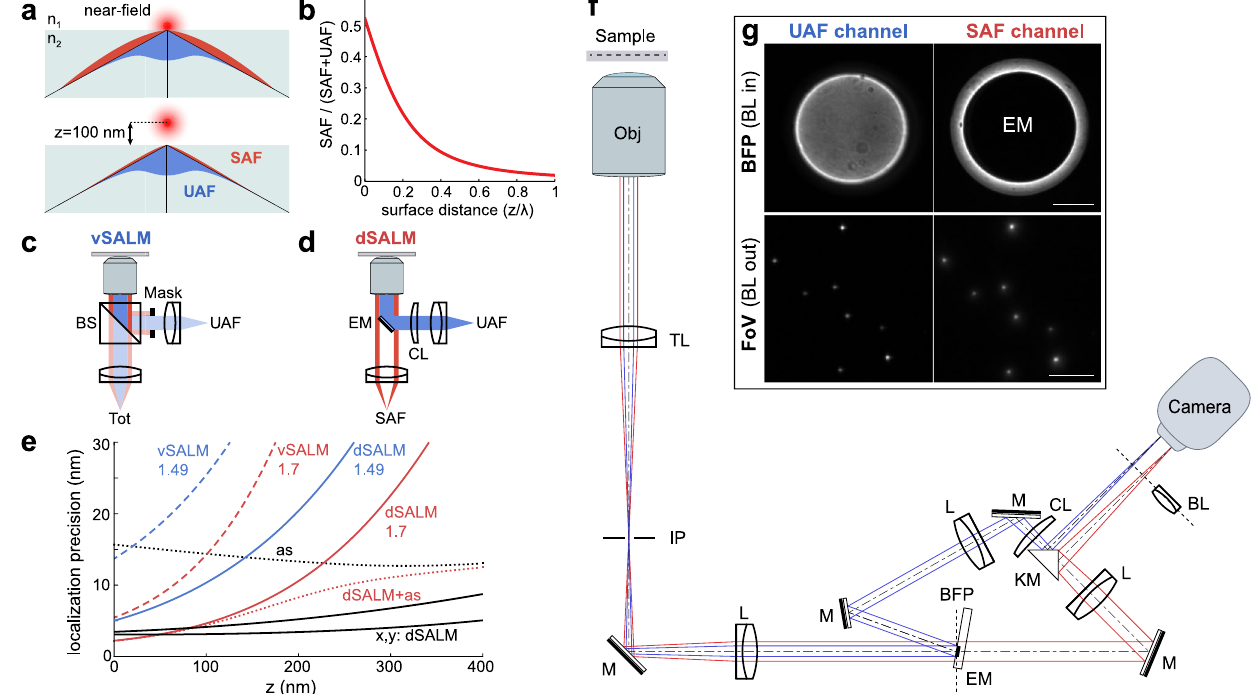
Fig. 1 Concept of supercritical angle localization microscopy (SALM). a Supercritical angle fl uorescence (SAF) occurs when a fl uorophore is close to a water-glass interface. b SAF depends strongly on the fl uorophore ’ s z position. c Virtual SALM (vSALM) splits the emission into two equal parts with a beam splitter (BS) and blocks out SAF with a mask in one channel. The z position of the fl uorophore is calculated from the ratio of total fl uorescence to undercritical angle fl uorescence (UAF). d Direct SALM (dSALM) splits SAF and UAF with an elliptical mirror (EM). An additional cylindrical lens (CL) in the UAF channel introduces weak astigmatism (as). e Theoretical localization precision in the axial direction calculated for an NA 1.49 objective in the vSALM con fi guration as used in refs. 14,15 (blue dashed line) and in the dSALM con fi guration (blue line), and for an NA 1.70 objective for vSALM (dashed red line) and dSALM (red line), astigmatism (black dotted line) and weighted average of dSALM and astigmatism (red dotted line). The solid black line indicates the lateral localization precision of dSALM (NA 1.70) in x and y, respectively. Calculations are based on experimentally derived PSFs (except dSALM 1.49, which is based on a theoretical PSF model) and assume 5000 photons detected in the UAF channel, and a background of 50 photons per pixel in the UAF channel and fi ve photons in the SAF channel. f Beam path for the dSALM implementation splitting SAF (red beam) and UAF (blue beam) before forming images of the sample on the camera. BFP back focal plane, BL Bertrand lens, CL cylindrical lens, EM elliptical mirror, IP image plane, KM knife-edge prism mirror, L lens, M mirror, Obj objective, TL tube lens. g UAF and SAF channels as seen on the camera with the Bertrand lens (BL) inserted in the beam path (upper panel) or without (lower panel). Scale bars are 2 mm (upper panel) and 5 µ m (lower panel). Source Data are available as a Source Data fi le